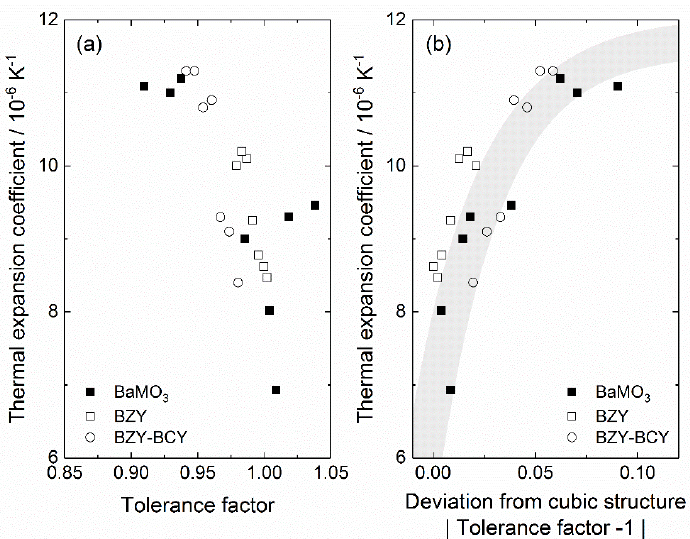
Figure 6. Linear thermal expansion coefficients for Ba-based perovskites from Tables 2 and 3 as a function of the Goldschmidt tolerance factor in ( a ), while ( b ) shows the same coefficients plotted versus the deviation from the perfect cubic structure, defined as the absolute value of (tolerance factor — 1).